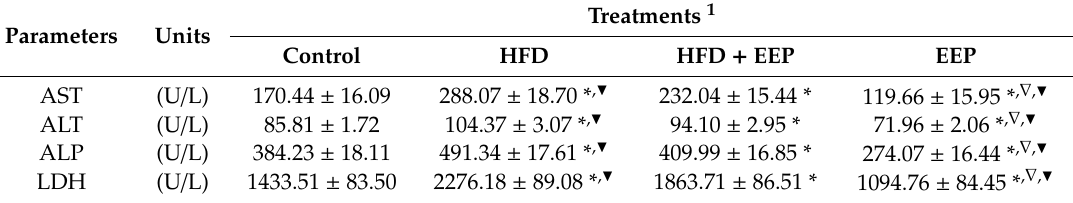
Table 6. E ff ect of ethanol extract of propolis on serum enzyme activities in high-fat diet fed mice. Parameters